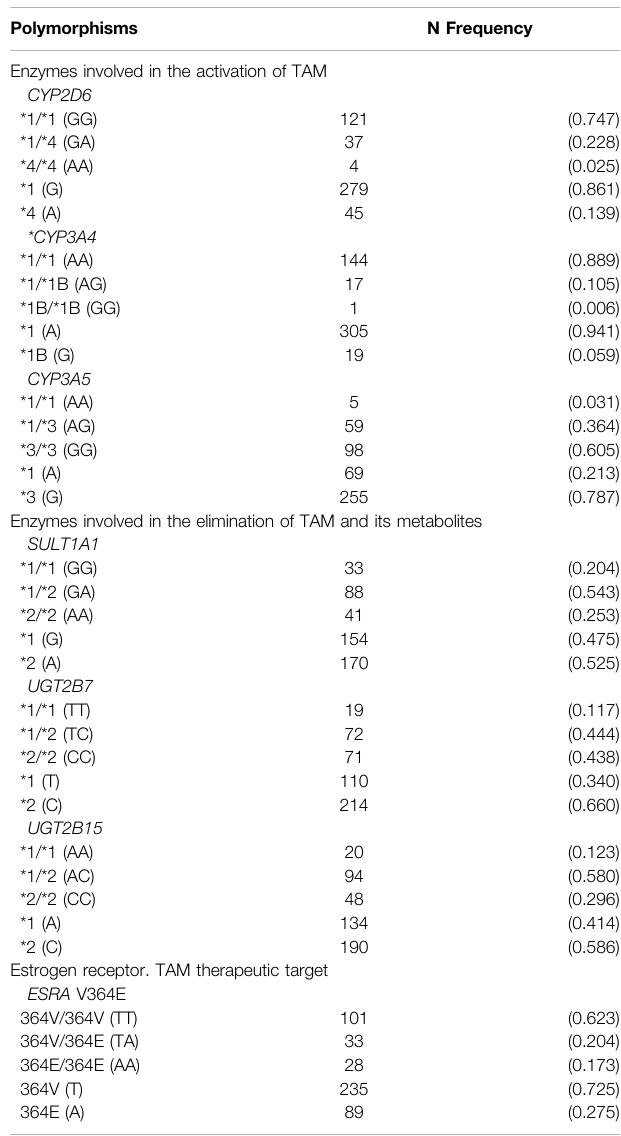
TABLE 3 | Genotype and allele frequencies of the studied polymorphisms in